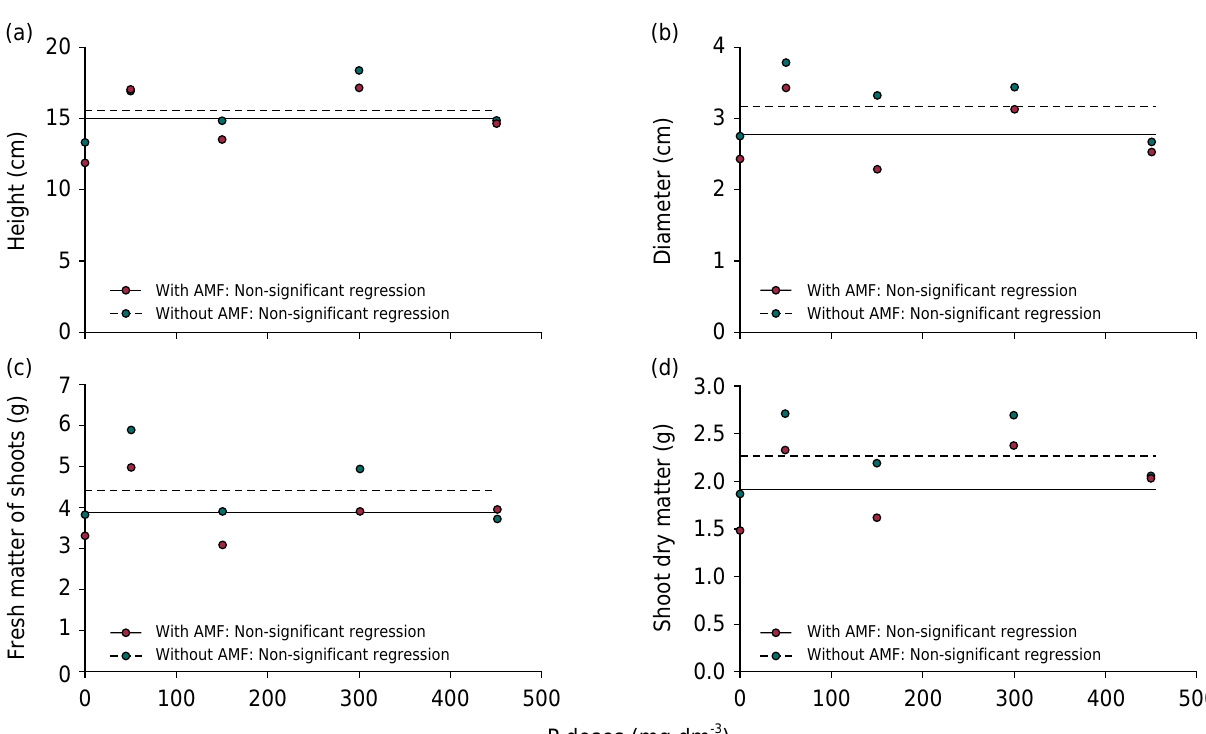
Figure 3. Response of M . brauna seedlings at doses of P (0, 50, 150, 300, and 450 mg dm -3 of soil), inoculated or uninoculated with a mixture of species of arbuscular mycorrhizal fungi ( Claroideoglomus etunicatum , Rhizophagus clarus , Gigaspora albida ), after 90 days of cultivation: (a) height; (b) diameter; (c) fresh, and (d) shoot dry matter.